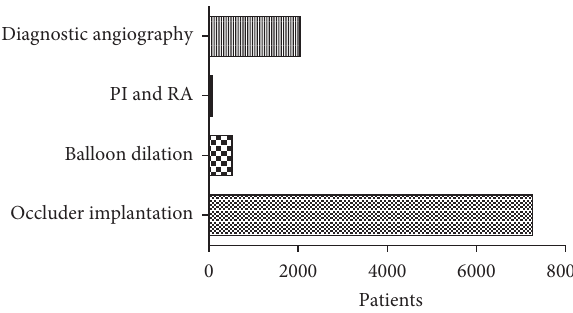
Figure 2: Operation diagram. PI � pacemaker implantation; RA � radiofrequency ablation.